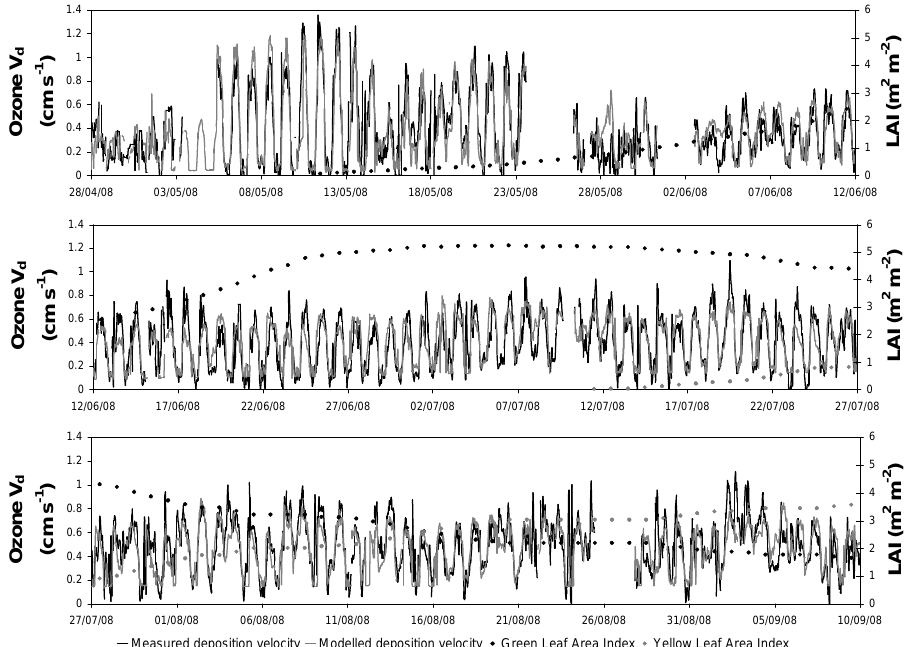
Figure 3: Time series of measured (black line) and modelled (grey line) ozone deposition velocities for the Grignon site from sowing (i.e. the 28 April 2008) to harvest (i.e. the 9 September 2008). Black and grey circles are Leaf Area Index for green and yellow leaves respectively. Table 2. Phenological stages of maize for Grignon, La Cape Sud and Lamasqu`ere sites during the study periods. Grignon La Cape Sud Lamasqu`ere Sowing 28 April 2008 NA Emergence 11 May 2008